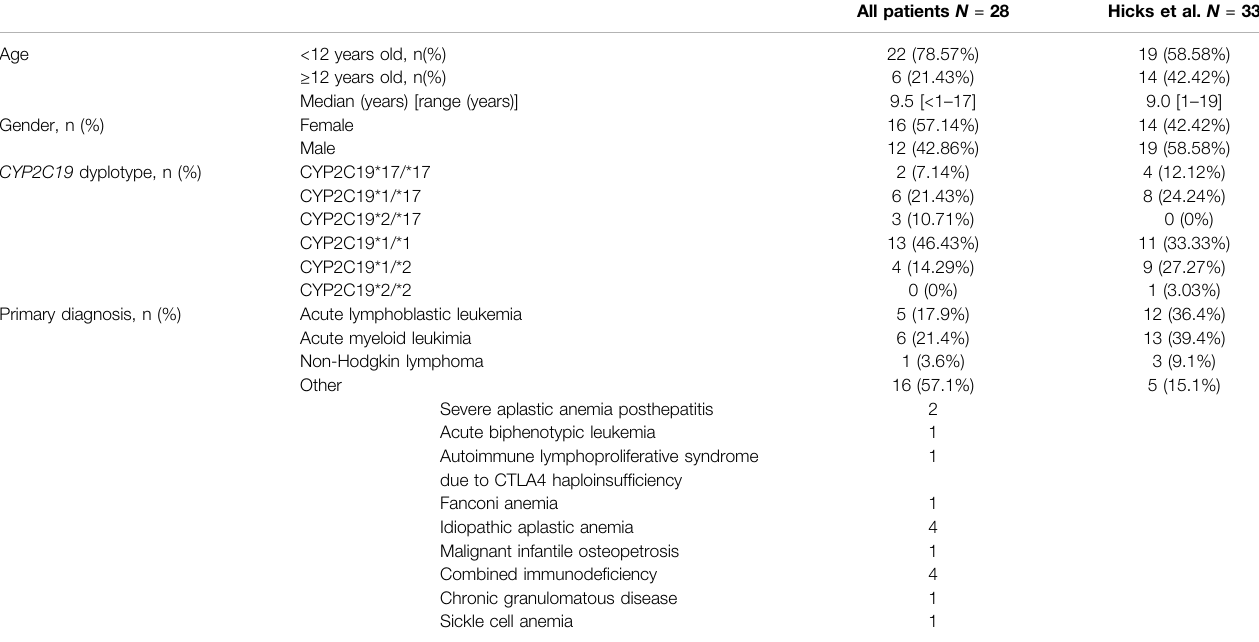
TABLE 1 | Patients characteristics ( N (cid:1) 28). Patients characteristics found in our cohort of the Spanish population are compared to those in Hicks et al. ’ s study ( N (cid:1) 33).